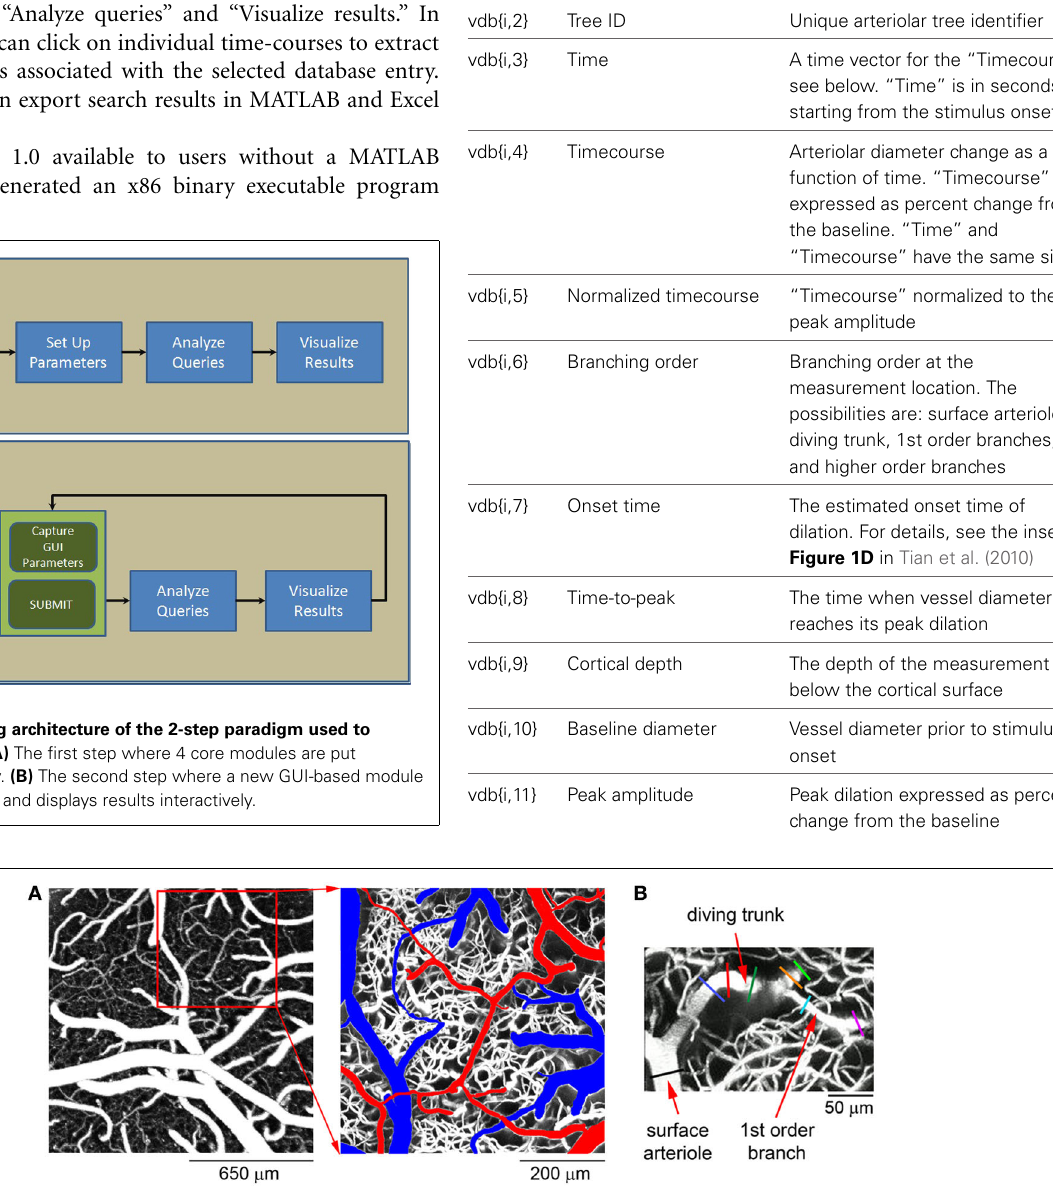
in red and blue, respectively. (B) MIP of an image stack 0–300 µ m in depth featuring a single diving arteriolar tree. For this specific example, diameter changesweremeasuredattheparentsurfacearterioleclosetothedivingpoint (black line), the diving trunk (blue, red, and dark green lines) and along 2 lateral branches at different cortical depths (orange, green, cyan, and purple